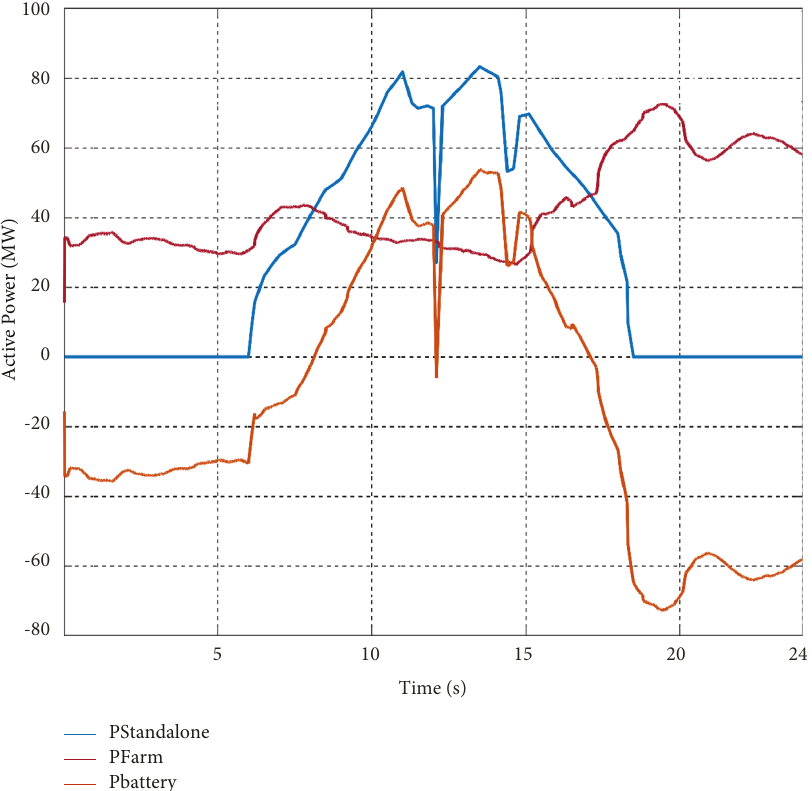
Figure 20: Active power output of the wind farm during load and wind speed step